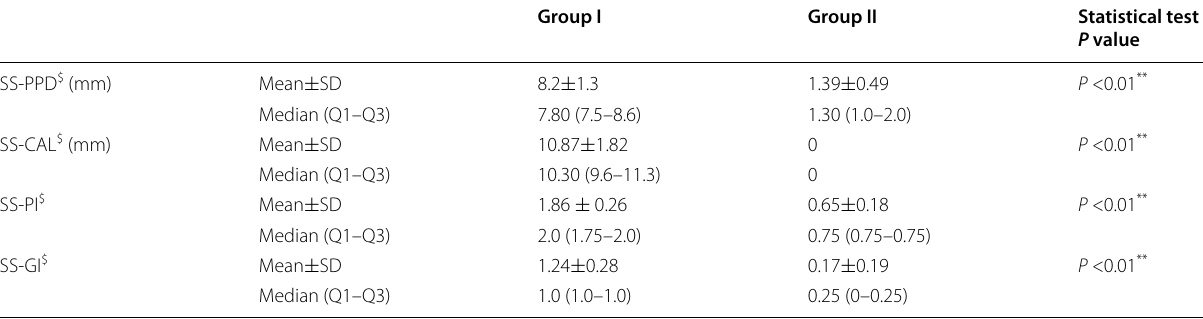
Table 2 Site-specific clinical parameters evaluated in groups I and II